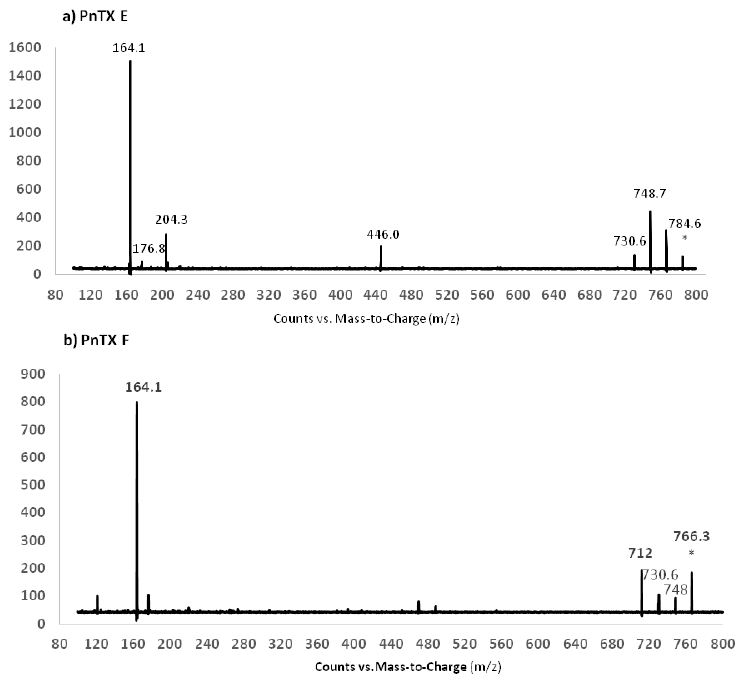
Figure 4. Product ion spectra of ( a ) m / z 784.6 of PnTX E from the hydrolyzed extract, and ( b ) m / z 766.3 of PnTX F from the non-hydrolyzed extract. * indicates the molecular mass of the toxin.